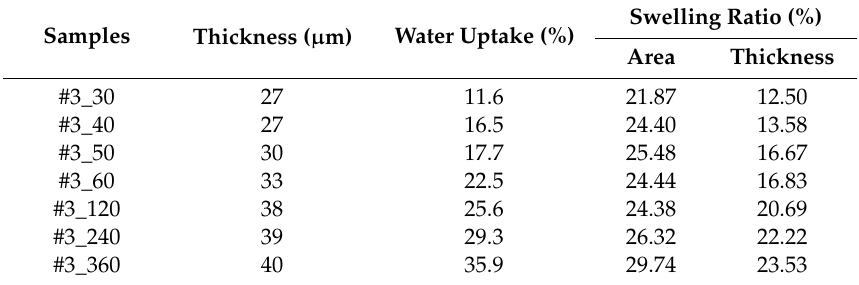
Table 5. Physical properties of composite membranes using Zeus porous substrates with incubation time in the GA / #3 solution.